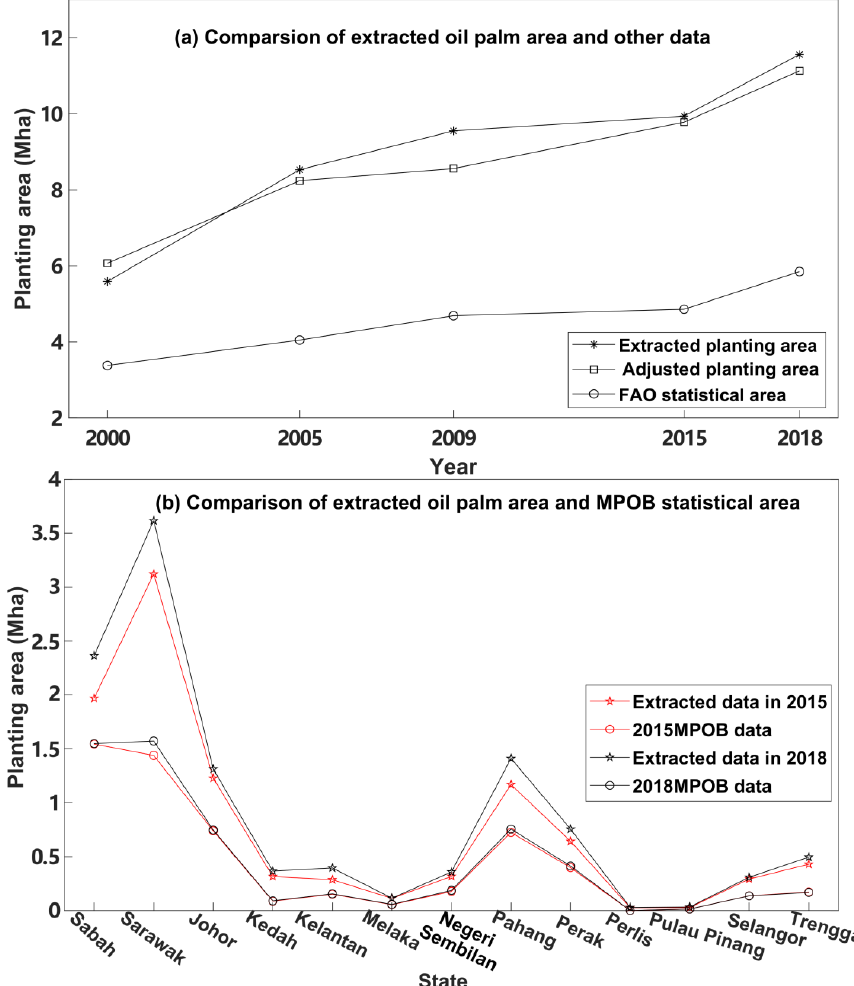
Figure 7. Comparison of the extracted oil palm area with the statistical areas of ( a ) the Food and Agriculture Organization (FAO) and ( b ) the Malaysia Palm Oil Board (MPOB). Agriculture Organization (FAO) and ( b ) the Malaysia Palm Oil Board